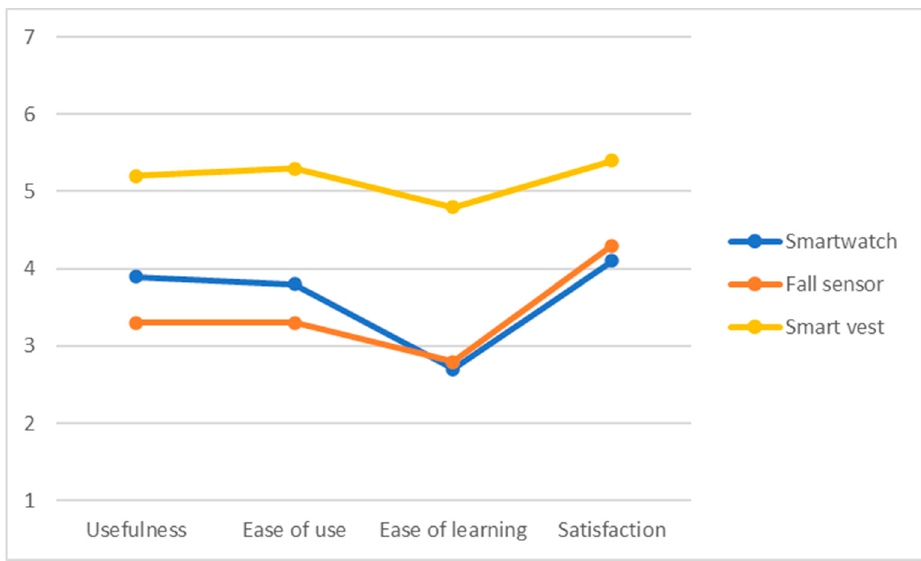
Figure 10. Results of USE questionnaire regarding the smartwatch, fall sensor, and smart vest.